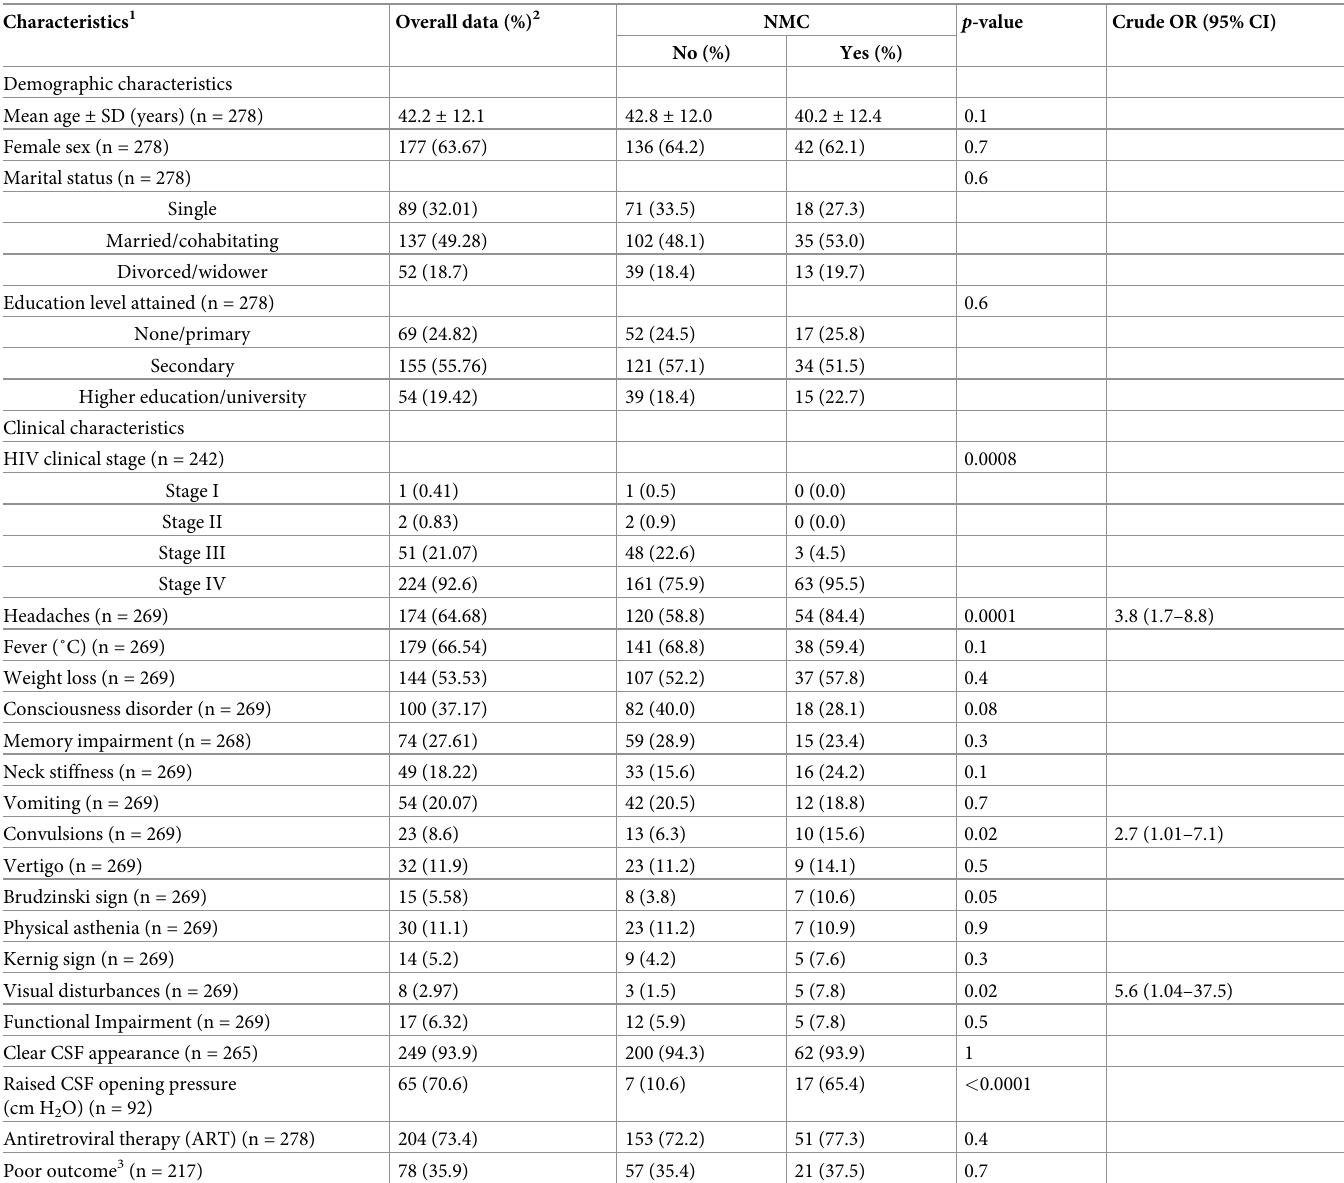
Table 1. Demographic and clinical characteristics of